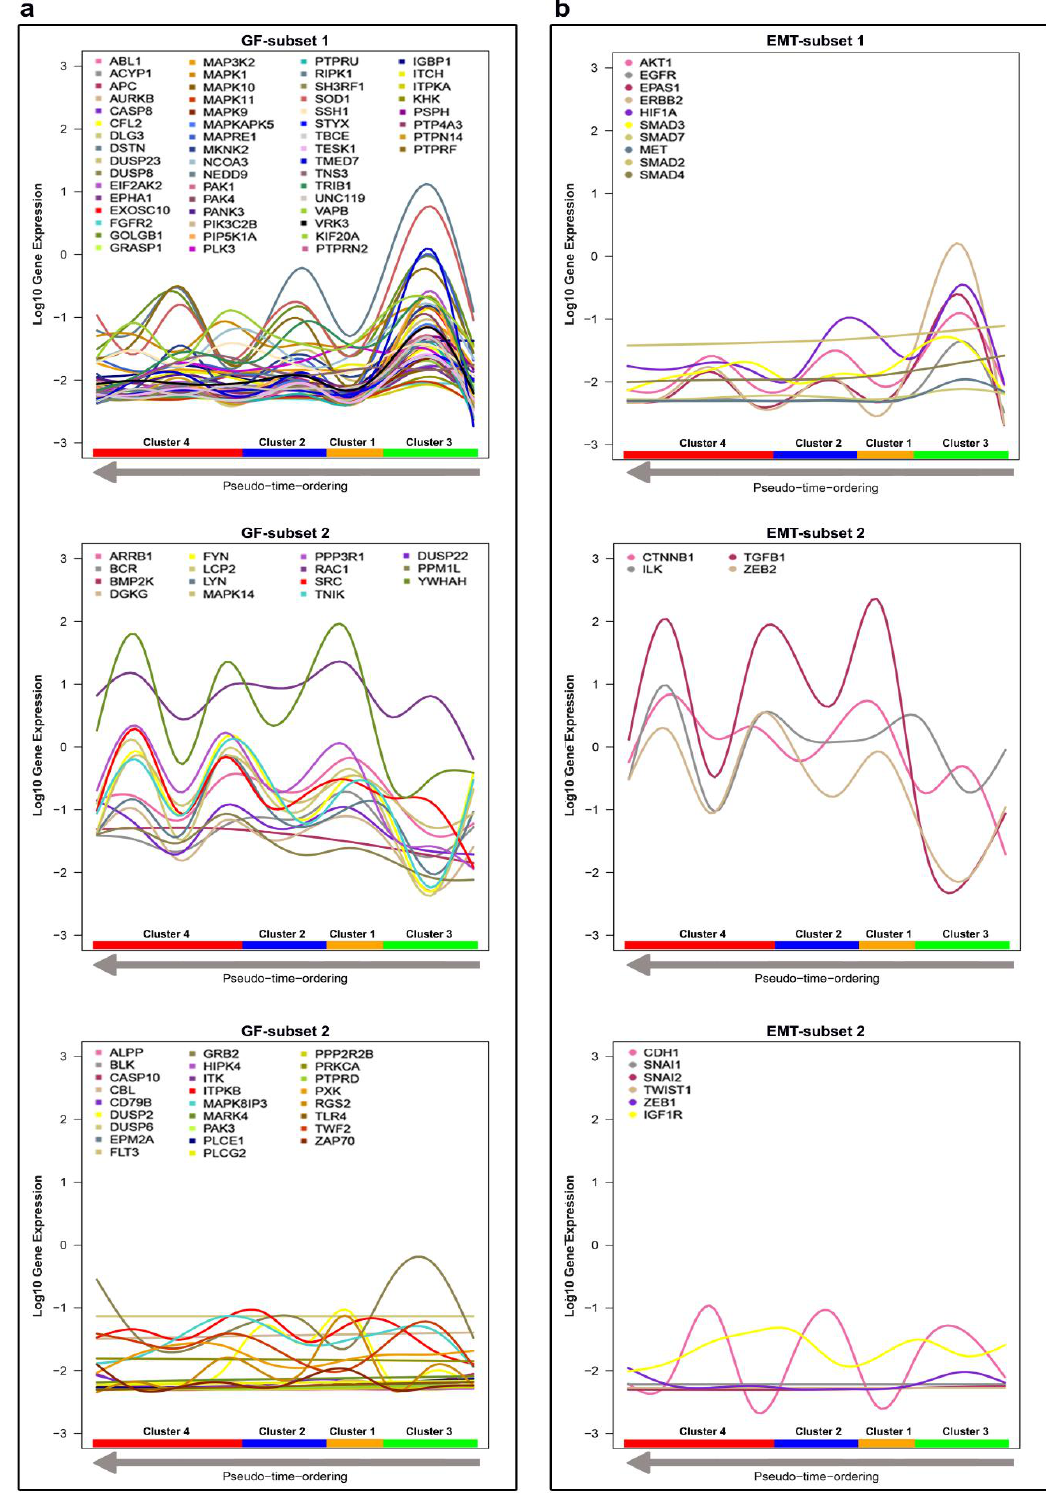
Figure 5. Discovery and exploration of the patterns in gene expression across the clusters, ordered from right to left based on pseudo-time ordering. The log10 gene expression values are shown on the vertical axis. Generalized additive mode smoothing is used to smooth the expression values per gene. ( a ) Gene expression profiling of the Golgi fragmentation gene list (97 genes). ( b ) Gene expression profiling of the EM gene list (20 genes).